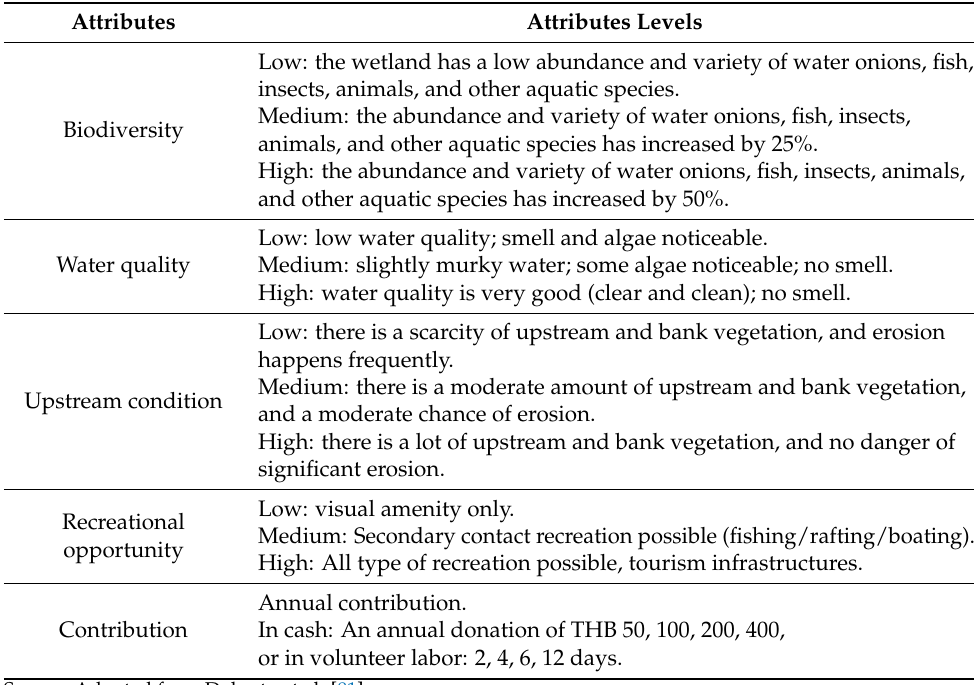
Table 1. The attributes and attribute levels of WO habitats used in the CE